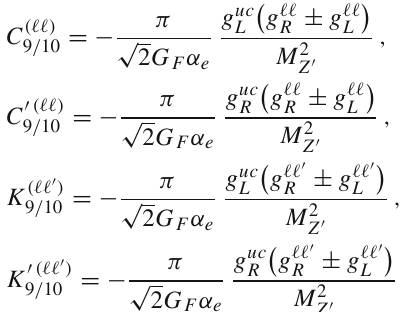
with X ∼ 20 for 1 TeV (cid:2) M Z (cid:3) (cid:2) 10 TeV. Main uncer-